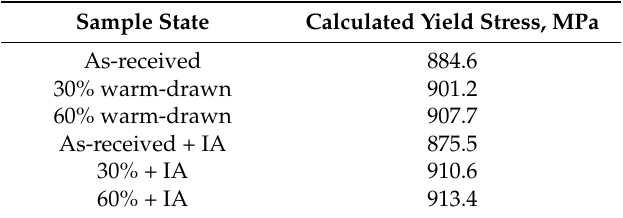
Table 4. Calculated yield stresses under different processing